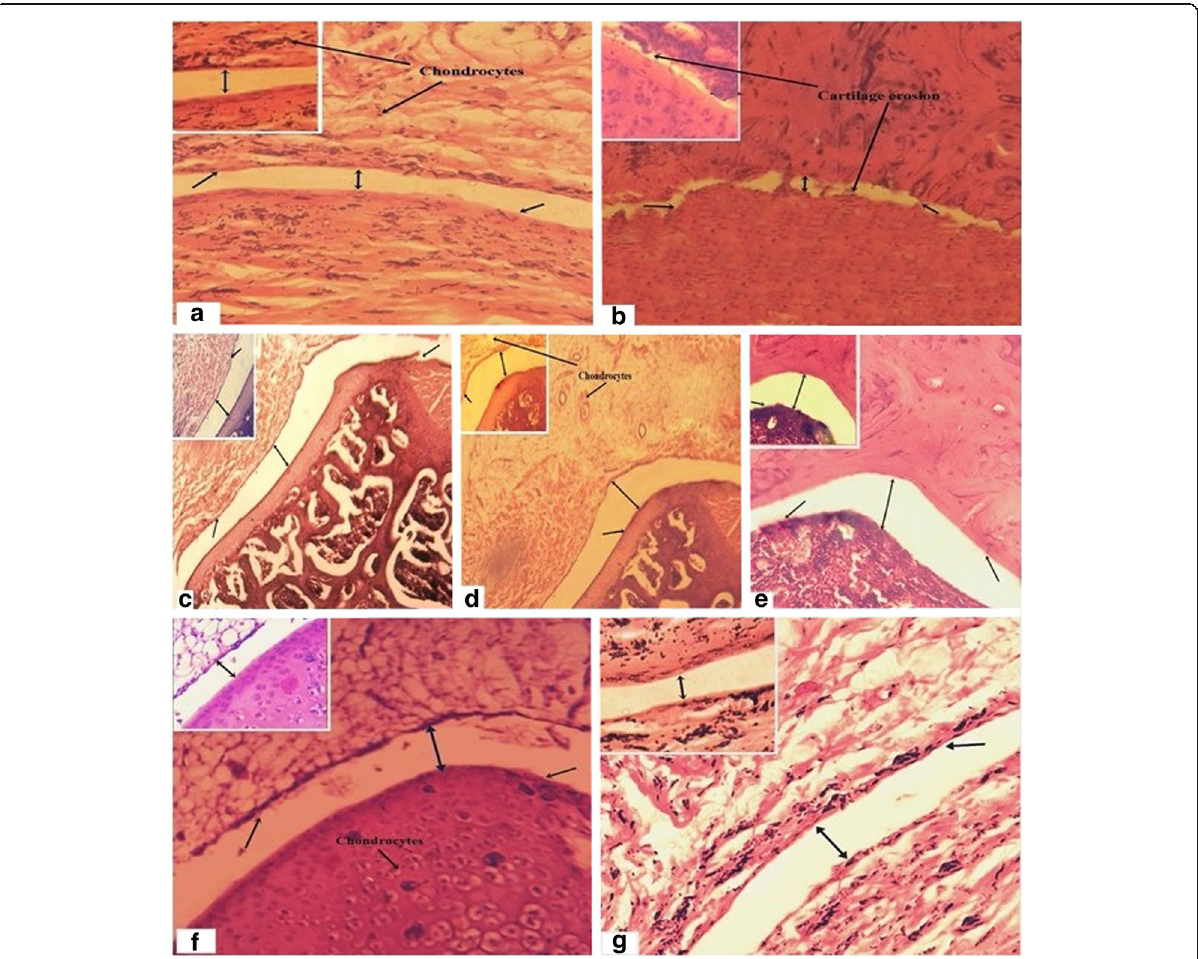
Fig. 7 Investigation of histological architecture ( a ) normal rat; ( b ) arthritic rat; ( c ) IPR-EA 300 mg/kg; ( d ) IPT-EA 300 mg/kg; ( e ) IPR-M 300 mg/kg; ( f ) IPT-M 300 mg/kg; ( g ) ibuprofen 10 mg/kg. The black double arrow shows variation in joint spaces among different groups, while single arrows represent the chondrocytes or cartilage erosion